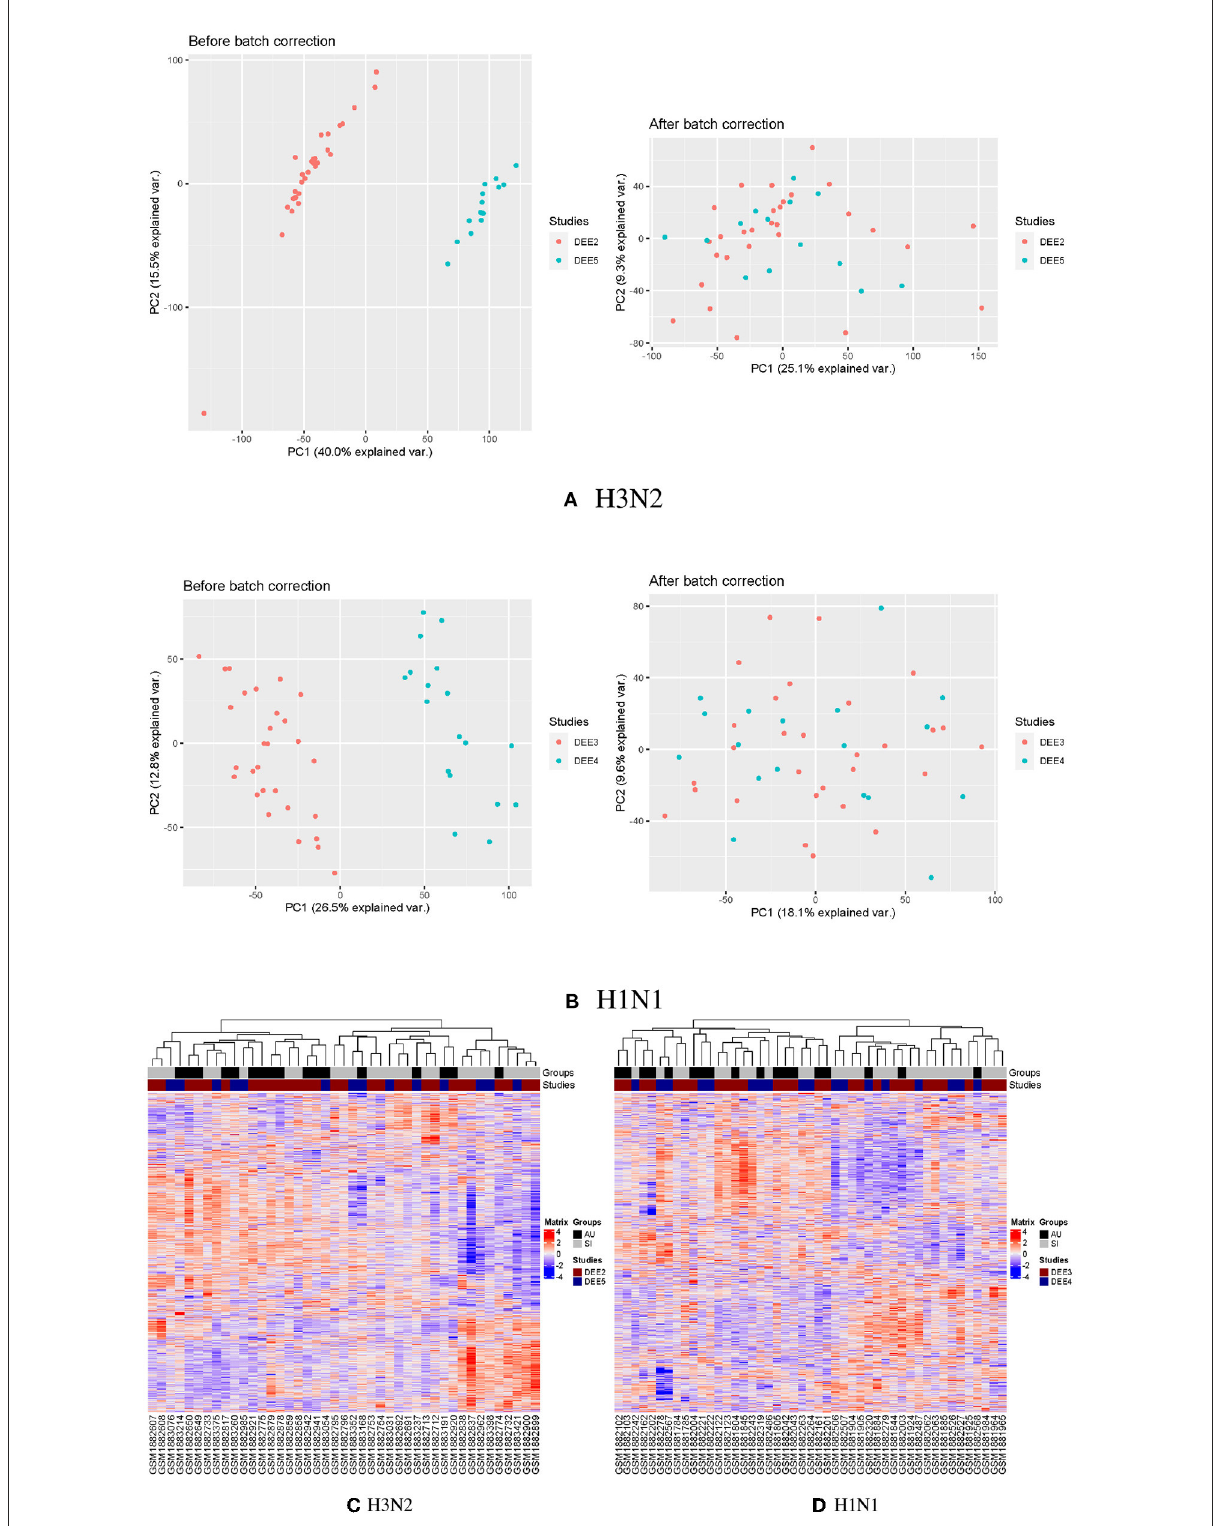
FIGURE1 Clustering analyses on the batch corrected profiles in the GSE73072 H3N2 and H1N1 cohorts. PCA analyses of GSE73072 H3N2 (A) and H1N1 (B) cohorts before and after batch effect correction. Clustering on the samples prior to inoculation in GSE73072 H3N2 (C) and H1N1 (D)